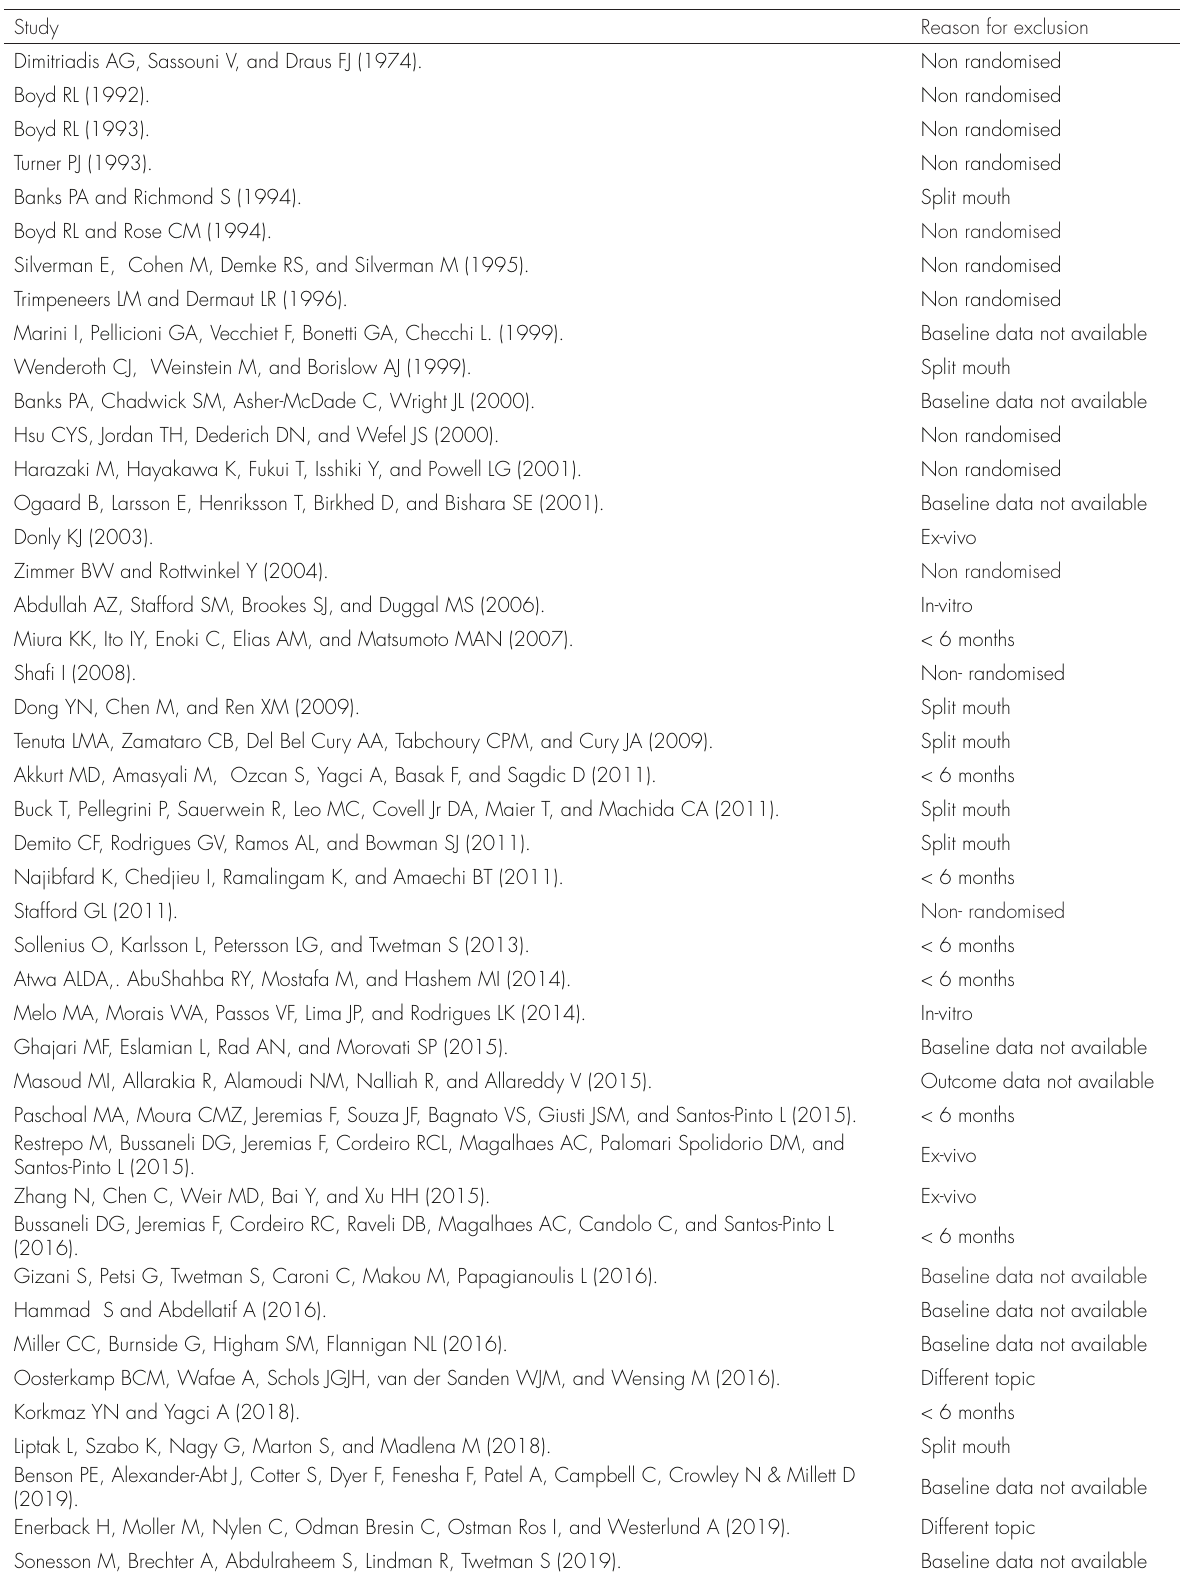
Supplementary Table II. Reasons for exclusion following full-text